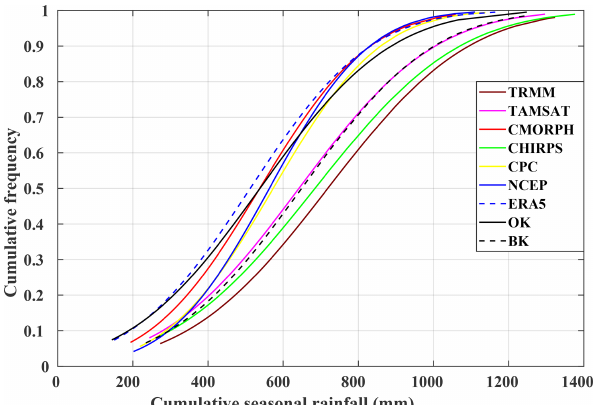
Figure 4. Distribution of cumulative distribution function (CDF) of amounts of the seasonal rainfall from June to October for the overlap period between datasets (1998–2010, in mm) using TRMM, TAMSAT, CMORPH, CHIRPS, CPC, NCEP, ERA5, OK, and BK. Details of the datasets are provided in Table